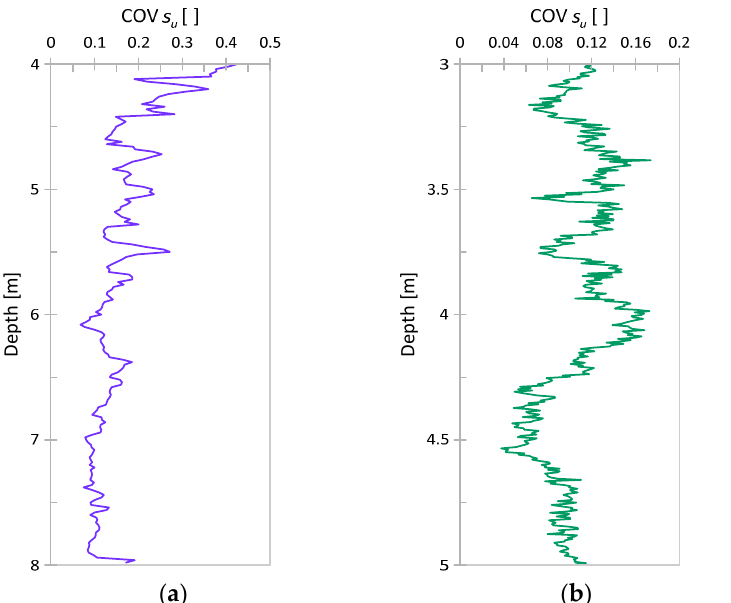
Figure 9. The COV of s u (based on CPT) vs. depth ( a ) CPTs for ´Swierzna clay ( b ) CPTs for Keswick clay. Table 4. Trends in COV values for s u obtained based on CPT results ( z is depth). Trends Equation Range of COV Values Soil Mean COV [-] [kPa] [-] Swierzna clay s u = 19.407 z + 19.539 0.068–0.425 0.152 Keswick clay s u = 22.495 z + 30.620